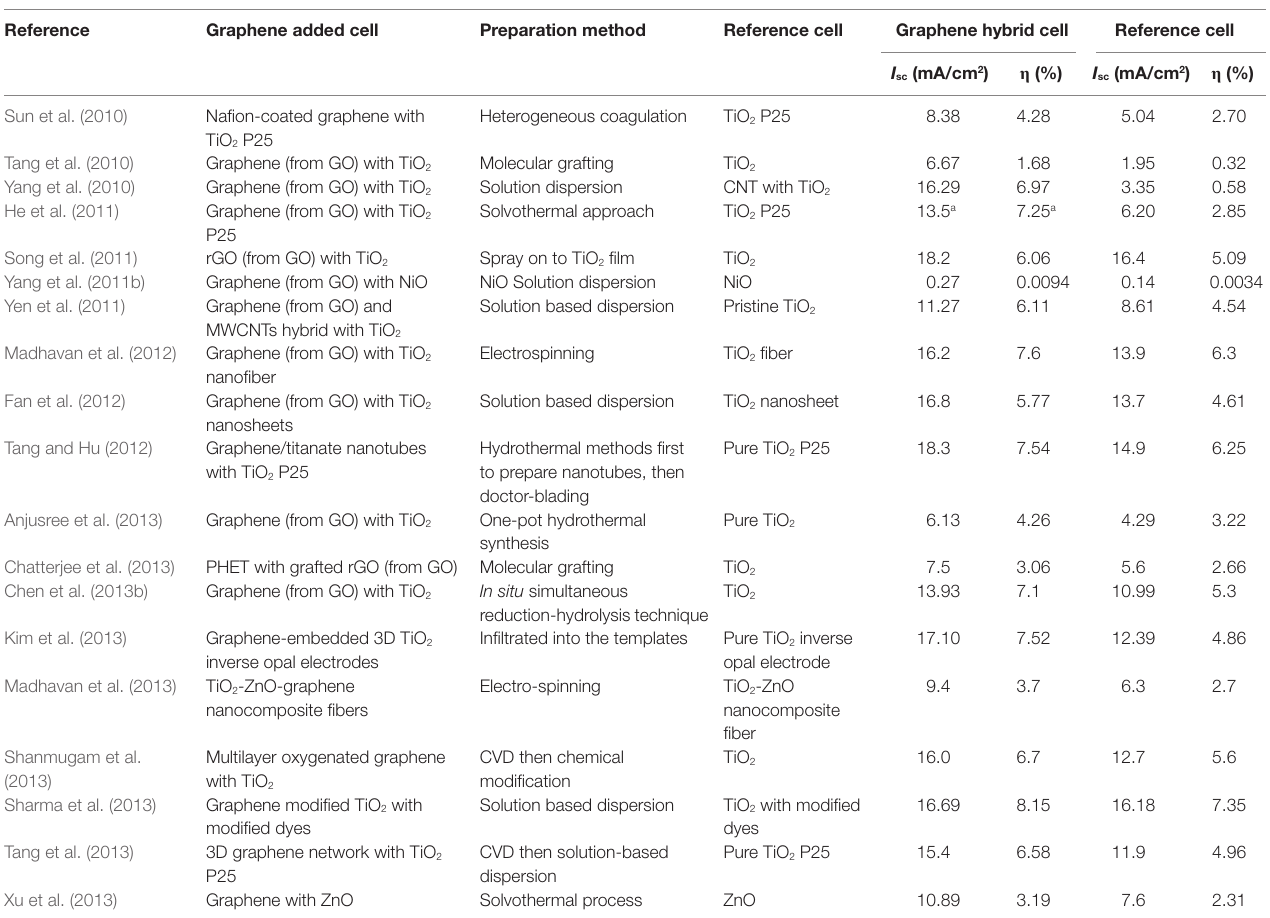
TABLe 1 | Comparison of graphene as photoanode